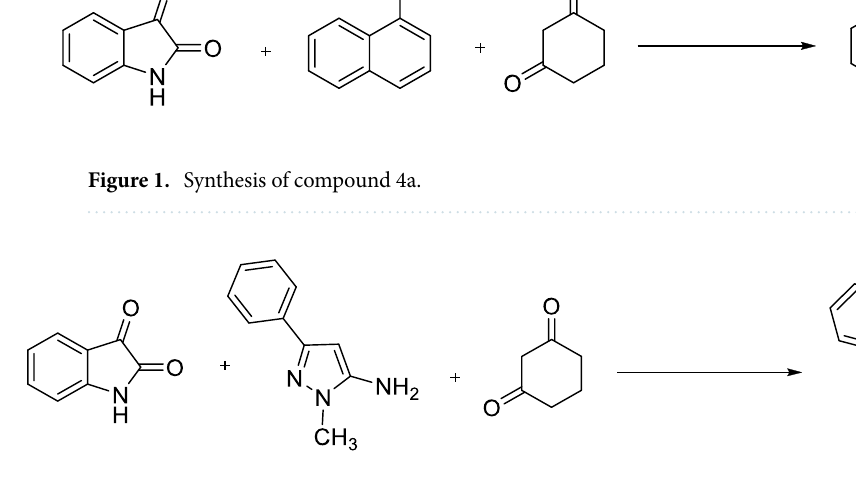
Figure 2. Synthesis of compound 6a.